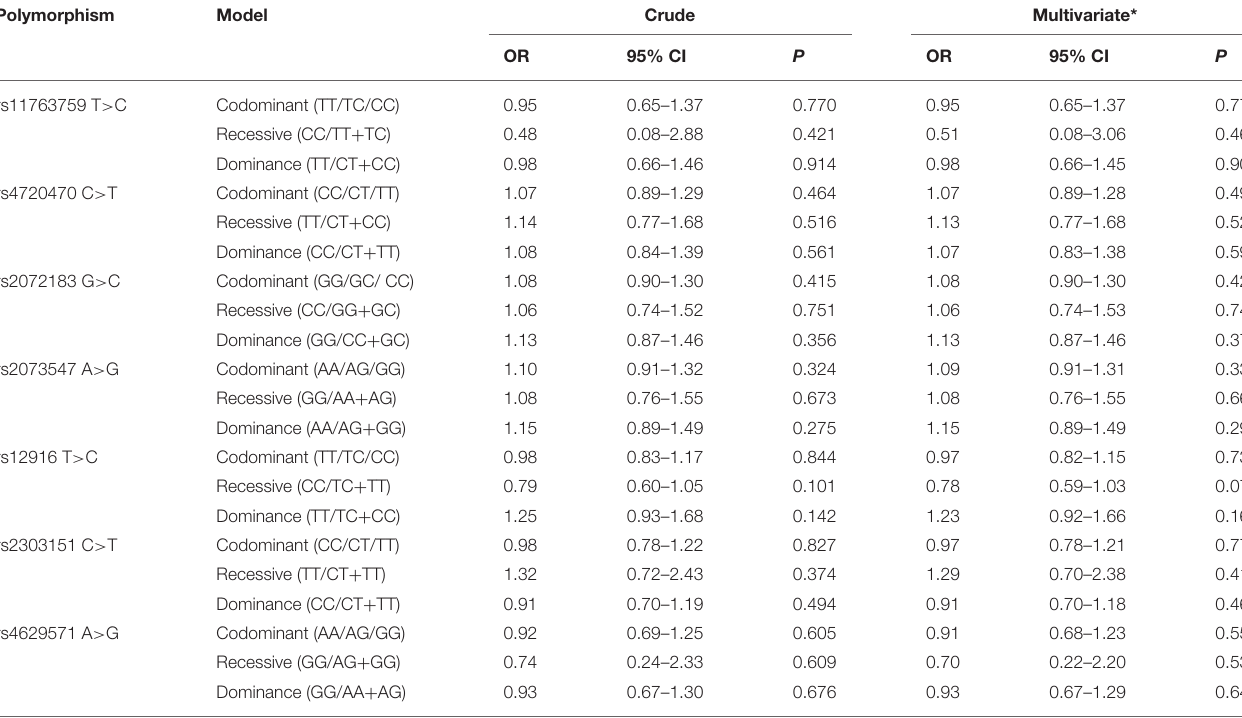
TABLE 6 | Univariate and multivariate adjusted logistic regression analysis of NPC1L1 and HMGCR gene SNPs and the SYNTAX score.